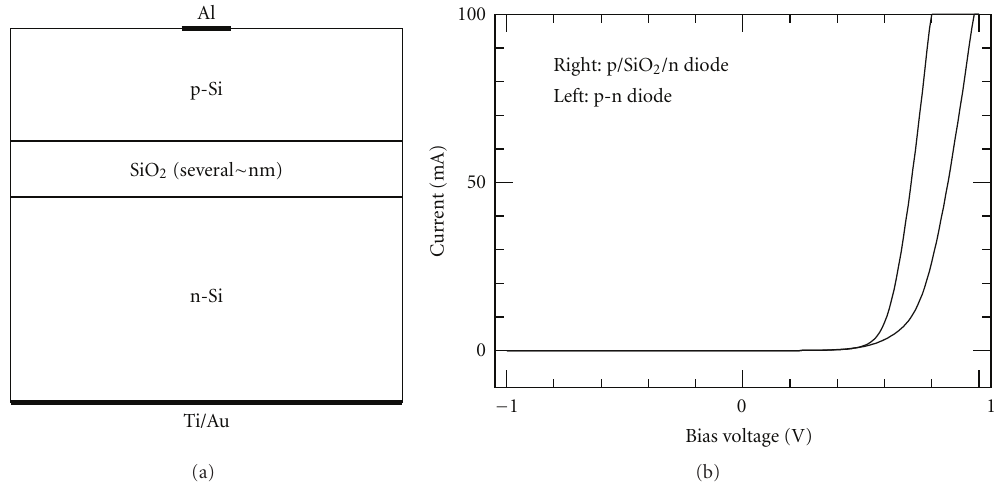
Figure 1: (a) Schematic structure of a p-Si/SiO 2 /n-Si diode. (b) V - I plots (right) of a p-Si/SiO 2 /n-Si diode compared with a p-Si/n-Si diode (left).